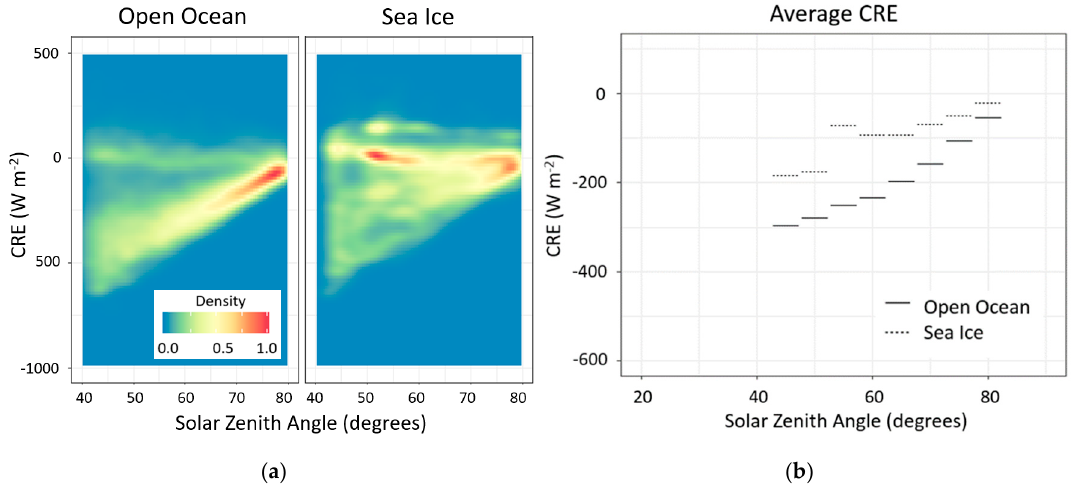
Figure 10. Distribution of net cloud radiative effect (CRE) versus solar zenith angle for ( a ) open ocean (left) and sea ice (right) with frequency of occurrence (density) scaled to 0–1 (blue to yellow to red). ( b ) Average CRE versus solar zenith angle in 5-degree intervals over open ocean (solid lines) and over sea ice (dashed lines). Data are from all voyages.